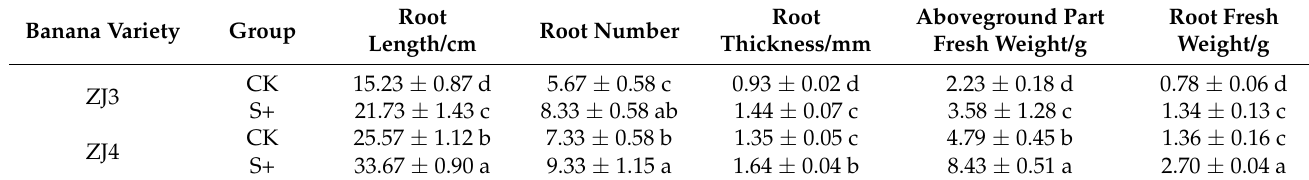
Figure 3. Effects of S. indica on the growth of ‘Zhongjiao No.3’ (ZJ3) and ‘Zhongjiao No.4’ (ZJ4) banana seedlings. CK: S. indica non-colonized controls; S+: S. indica colonized banana seedlings; mpt: months post-transplanting.